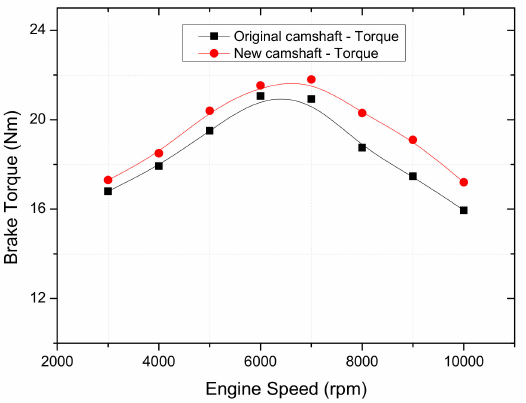
Figure 15. Comparison of brake torque between the original and new valve